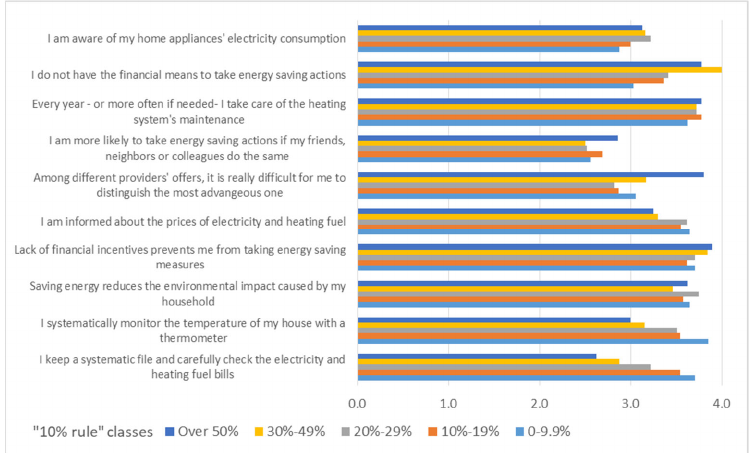
Figure 11. Behavioral statements by energy ‐ vulnerable and non ‐ vulnerable households—“ten per ‐ cent rule” indicator.